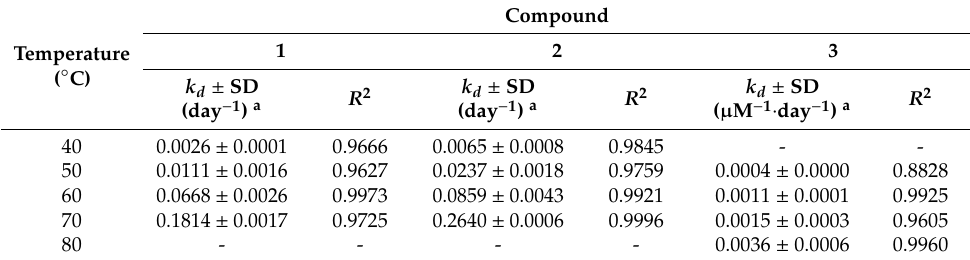
Table 1. Degradation rate constants for compounds 1 – 3 in dried AE powder, estimated by the mean of a first-order kinetic model for compounds 1 – 2 and a second-order kinetic model for compound 3 .